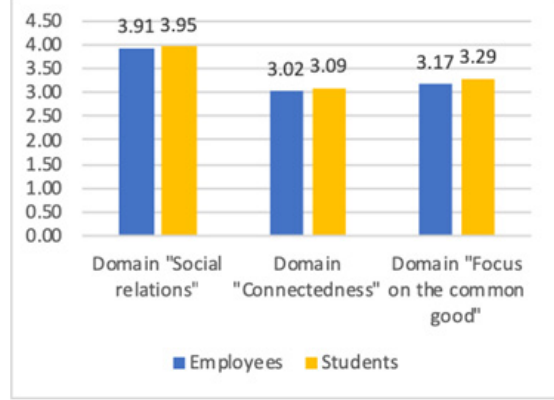
Figure 5. Comparison of social cohe- sion between employees and students by do- mains